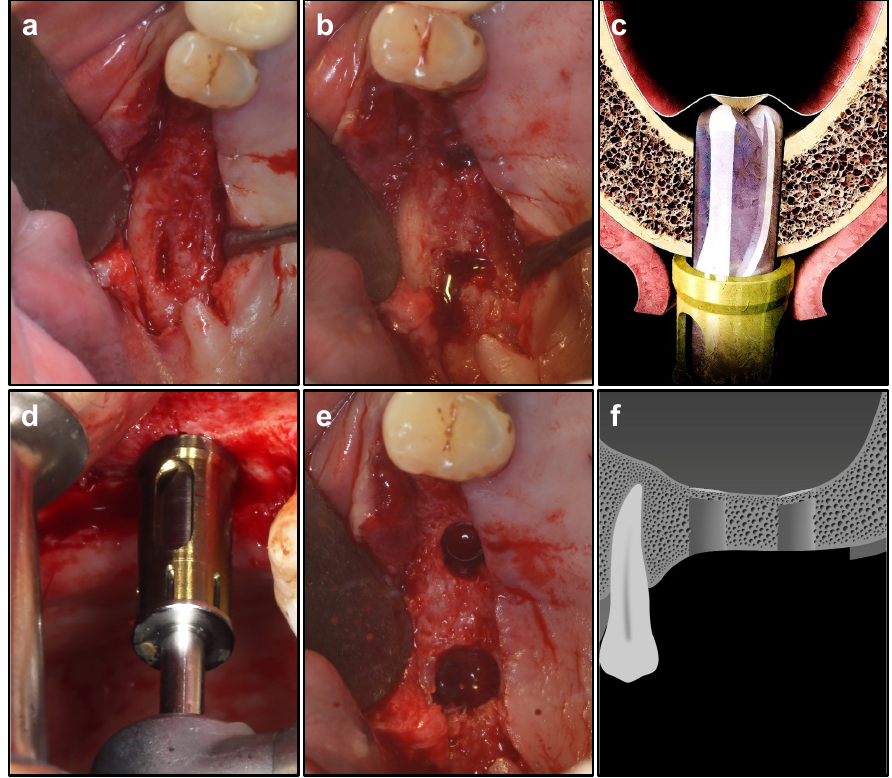
Figure 2. Sinus floor preparation. ( a ) performing H incision on teeth 16 and 17. ( b ) drill prepara- tion. ( c ) Crestal Approach Sinus Kit (CAS) drill simulation. ( d ) using CAS drill for preparation. ( e ) integrated membrane after CAS drill preparation. ( f ) schematic diagram after drill